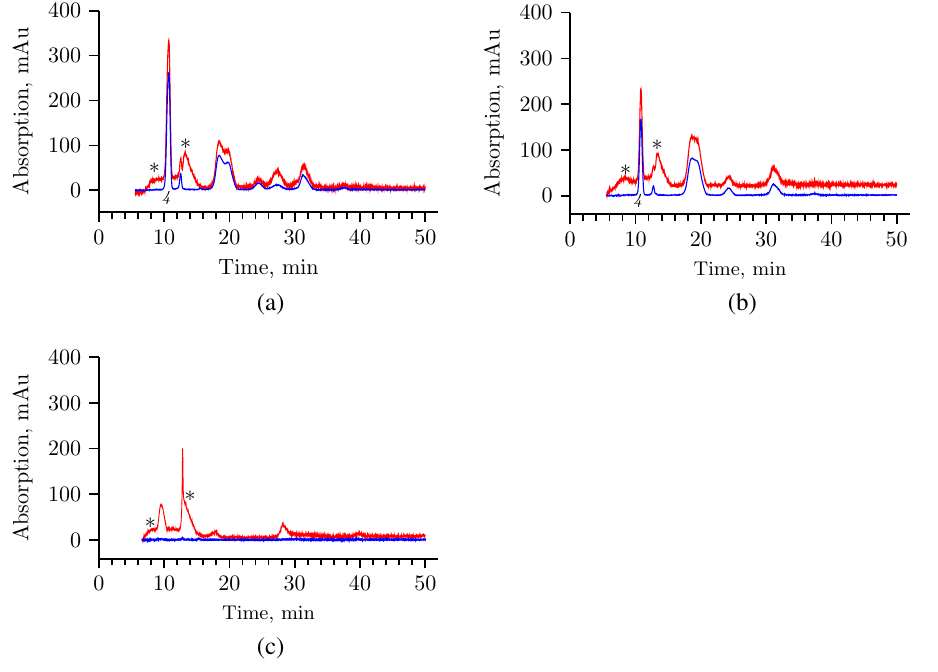
Figure 7. Ion-exchange chromatography of the reaction mixtures containing HA after treatment by: ( a ) S. hyalurolyticus lyase, ( b ) HPC homogenate, ( c ) leech head homogenate. UV absorbance at 210 nm, UV absorbance at 232